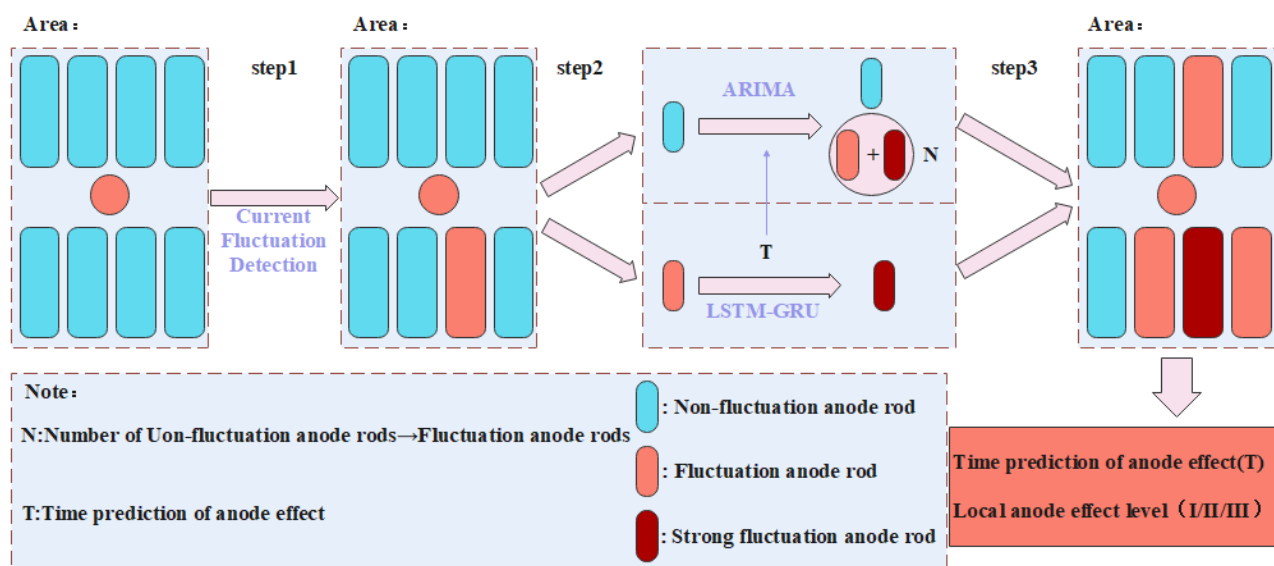
Figure 4. Flow diagram for prediction of local anode effect.